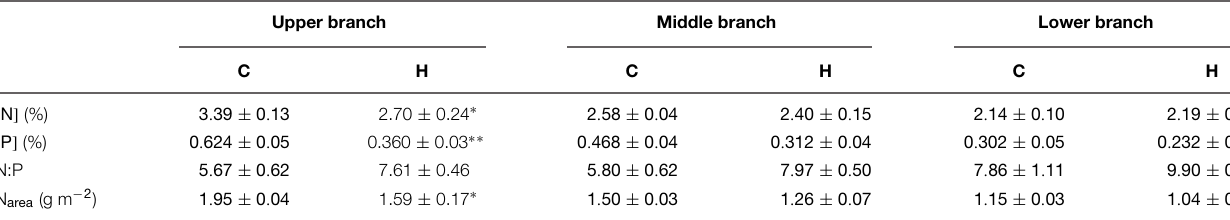
TABLE 5 | Means of leaf parameters in three crown positions.